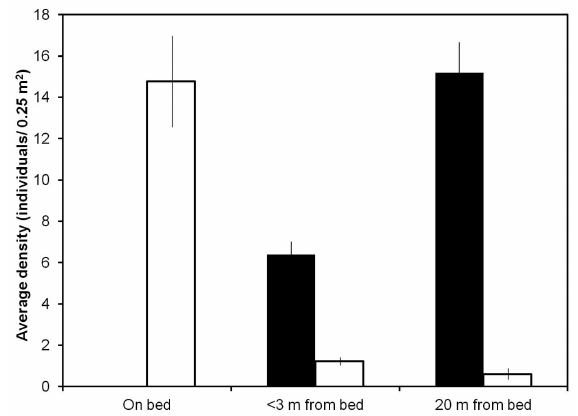
Fig. 2. – The density of live Mimachlamys asperrimus (doughboy scallop) was lower near and on the shell bed than at a distance of 20 m (dark bars). The density of hermit crabs (species not distinguished during counts) was higher on the shell bed than at a distance of 20 m (open bars). See text and Figure 5 for hermit crab species.